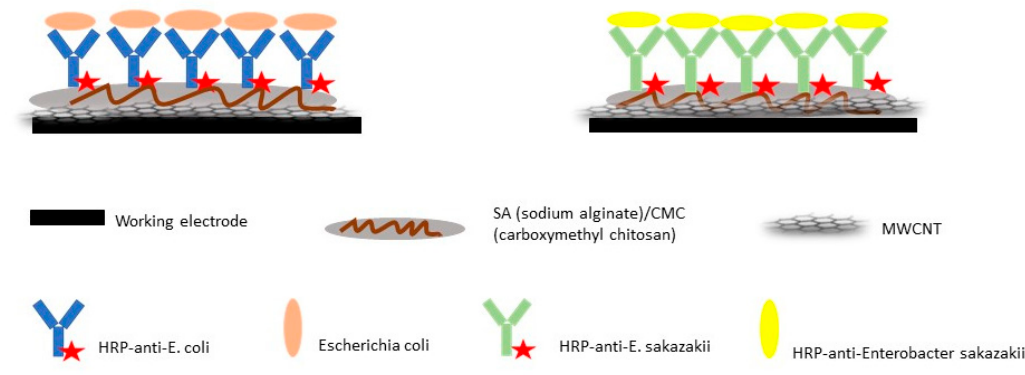
Figure 2. Structural illustration of the immuno-electrodes for the determination of E. coli O157:H7 and E. sakazakii [14].